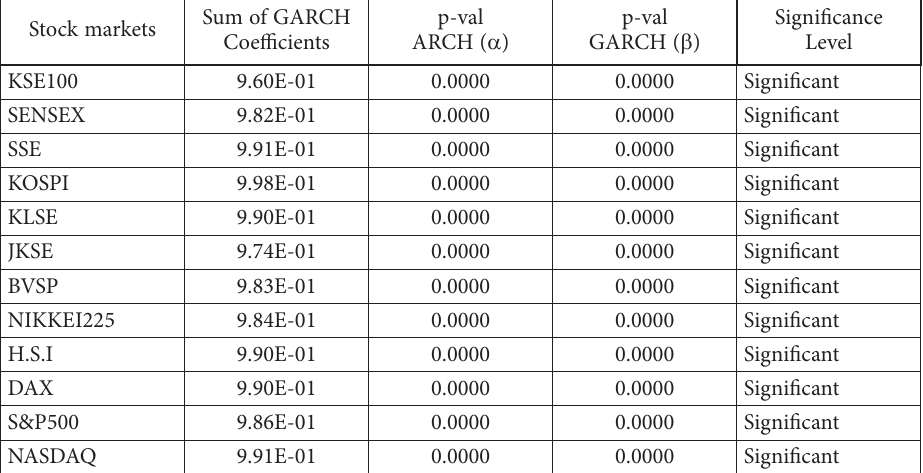
Table 9. Significant and insignificant ARCH and GARCH effects for mean reversion Stock markets